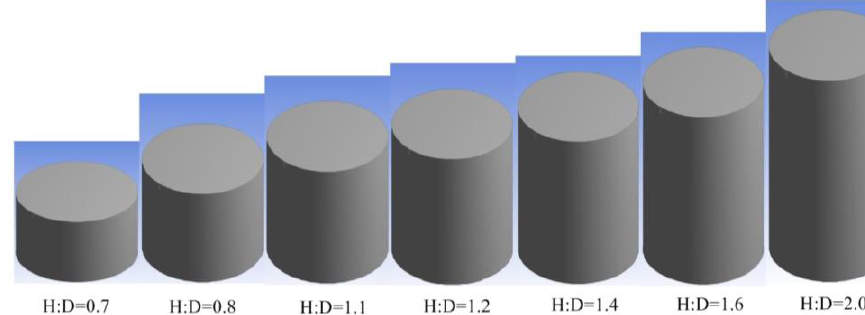
Figure 3. 3D shapes with different H:D ratios.